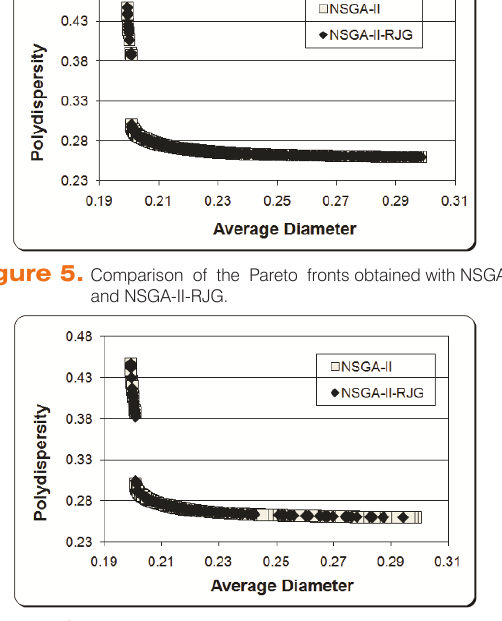
Figure 6. Comparison of the Pareto fronts obtained with NSGA-II and optimized